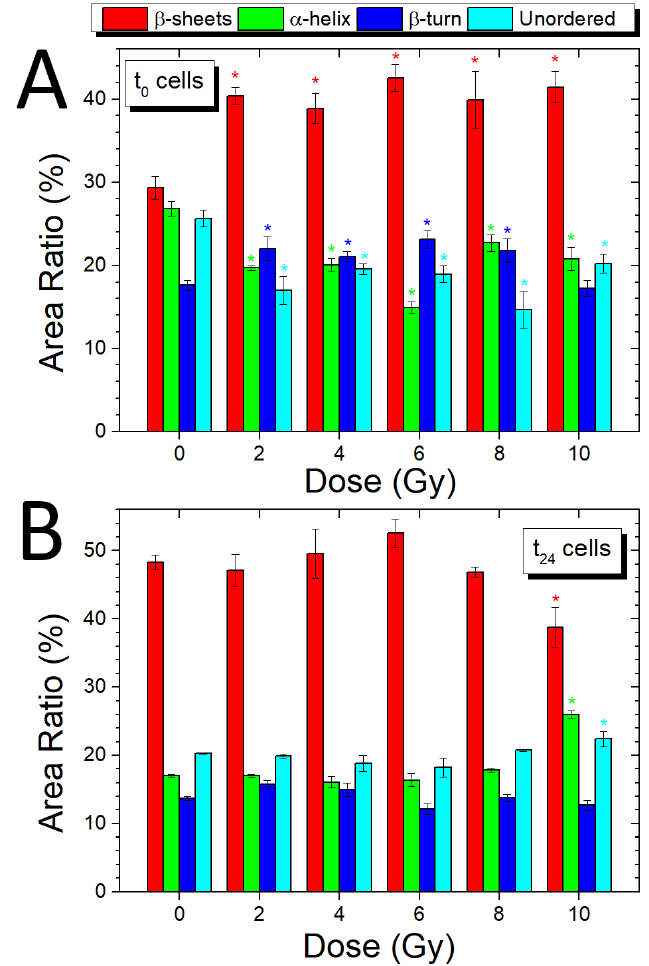
Figure 8. Variations of secondary protein structure contributions to Amide I band (1590–1710 cm −1 ) with dose, for cells fixed immediately ( A ) and 24 h after irradiation ( B ); the ratios between the secondary structures peaks area and the area of the entire Amide I peak are reported; asterisks of different colors indicate when a significant difference in respect to the corresponding control value occurred at 𝑝 ≤ 0.05 .